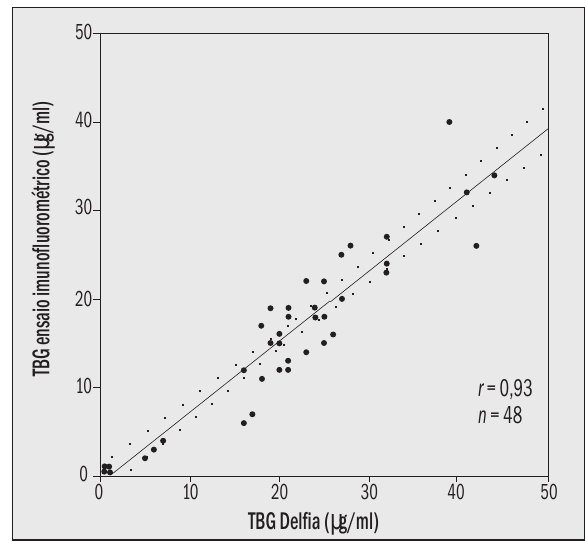
Figura – Correlação entre os resultados de TBG sérica obtidos com um ensaio comercial (Delfia) e com o ensaio descrito neste trabalho (ensaio níveis de TBG eram indetectáveis pelo método em estudo. Foram 19 indivíduos do sexo masculino e um do sexo femi- nino, sendo que oito dos indivíduos tinham menos de um ano de idade por ocasião do estudo. Em todos o valor de